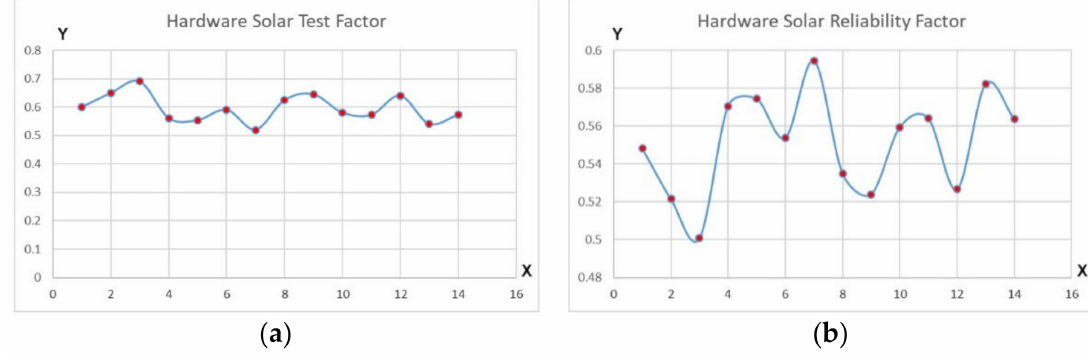
Figure 8. Hybrid testing suite for hardware test scenarios: ( a ) hardware STF generated according to the total number of stuck-at-faults; X -axis representing the number of days; Y -axis representing the hardware STF parameter; ( b ) hardware SRF generated according to the hardware STF parameter; X -axis representing the number of days; Y -axis representing the hardware SRF parameter; adapted from [16]